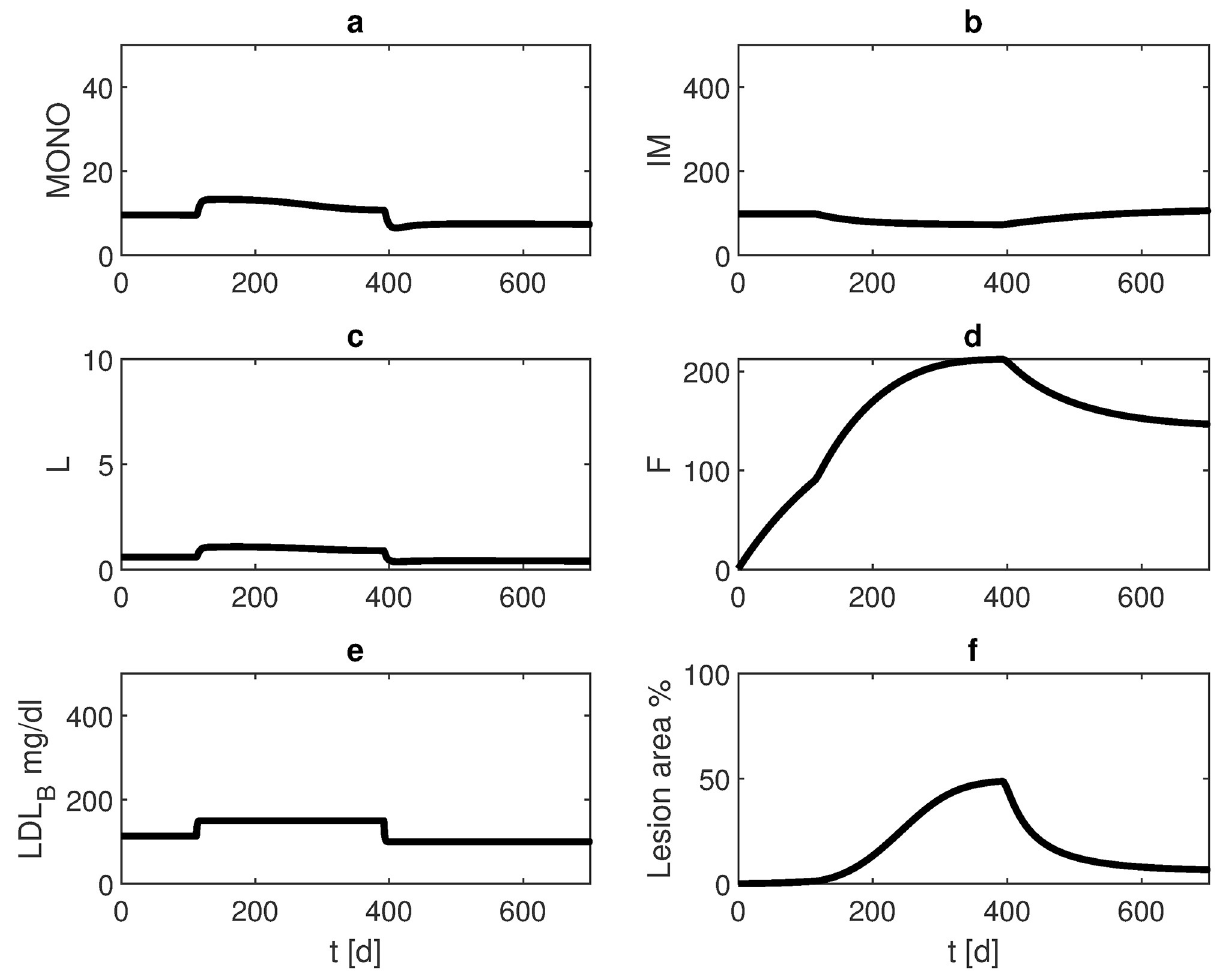
Fig 11. Propionic acid after high fat diet. HFD is given from week 16 until week 56. PA is applied between week 57 and week 100. The curves represent model results of a) monocytes in plaque, b) macrophages in plaque, c) LDL-C in plaque, d) foam cells, e) LDL-C in blood, and f) lesion area. The lesion regresses under lipid